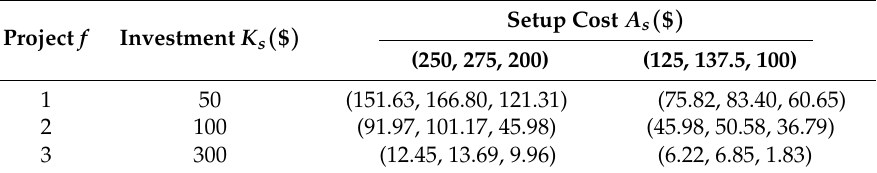
Table 3. Setup cost versus investment